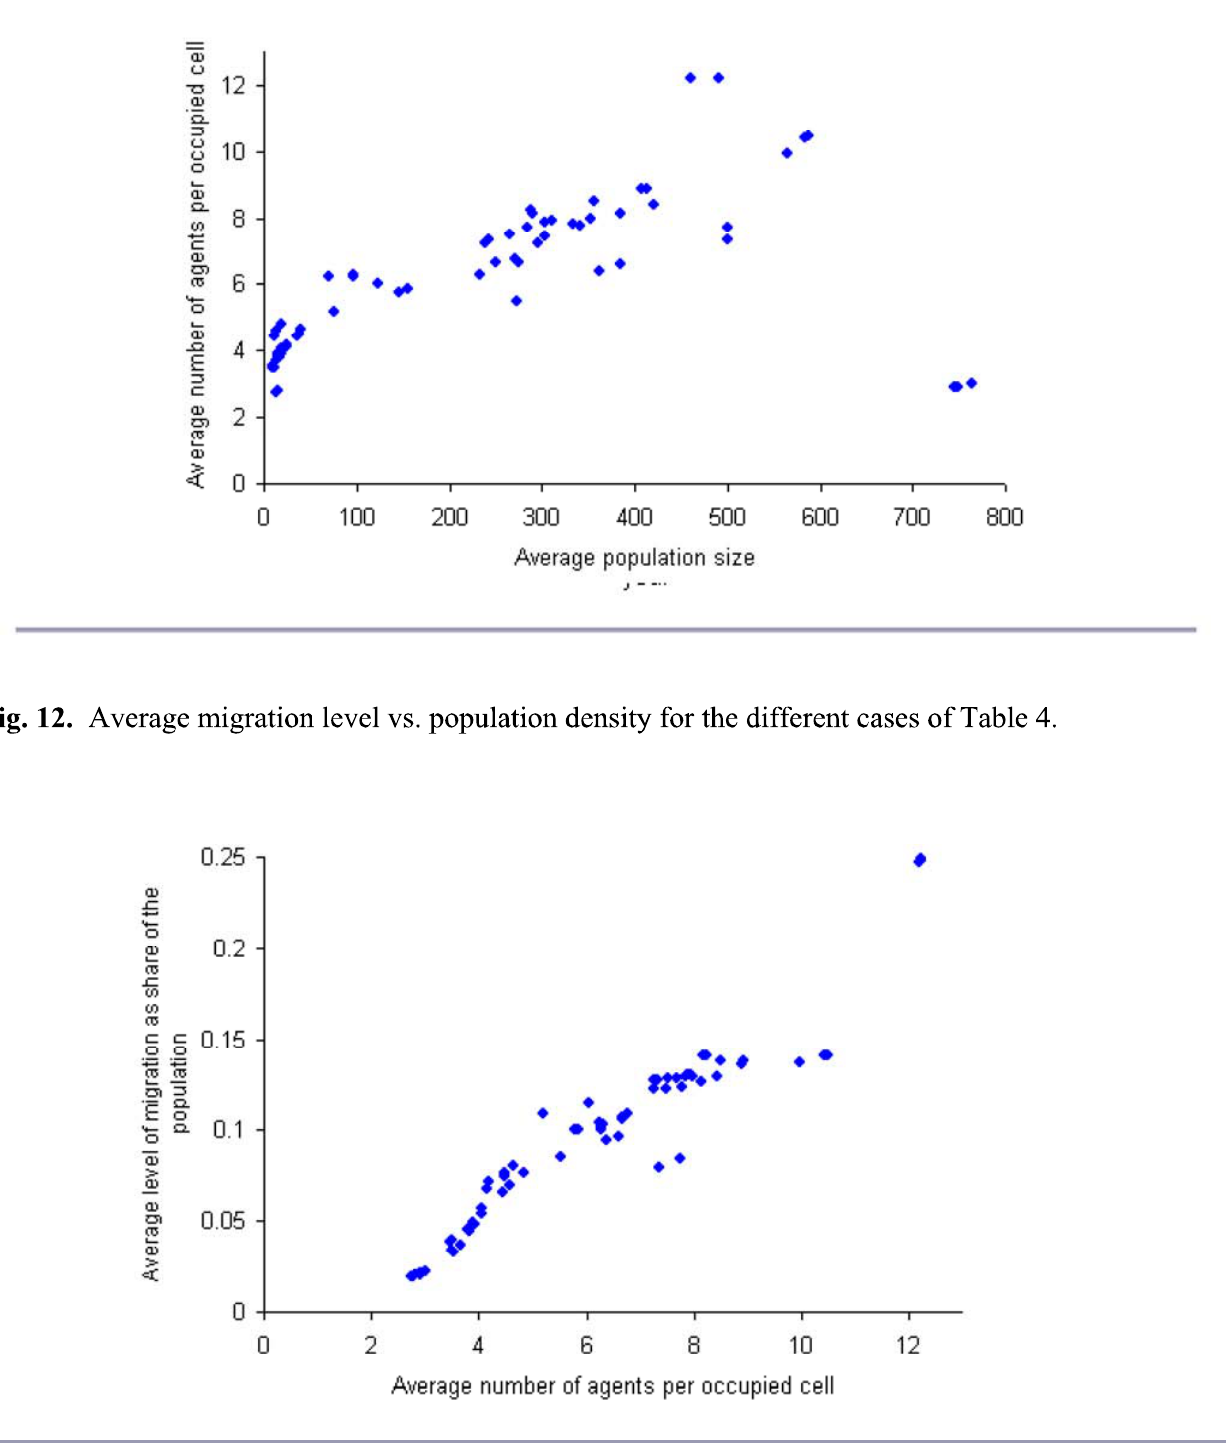
Fig. 11. Average density vs. population size for the different cases of Table